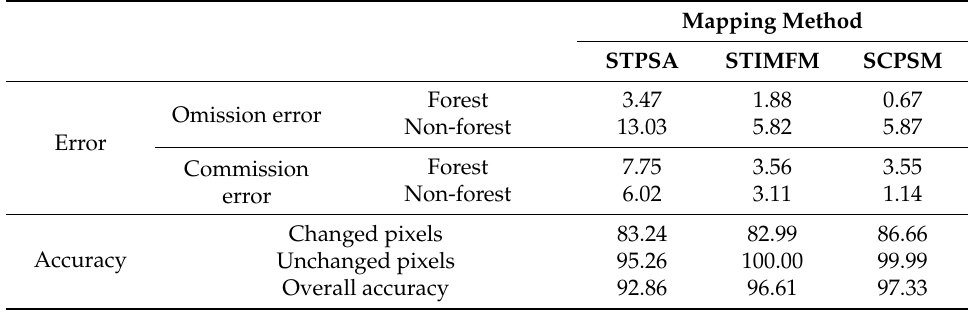
Table 3. The error and accuracies (%) for changed pixels, unchanged pixels and all pixels (overall accuracy) of di ff erent methods in the forest clearance